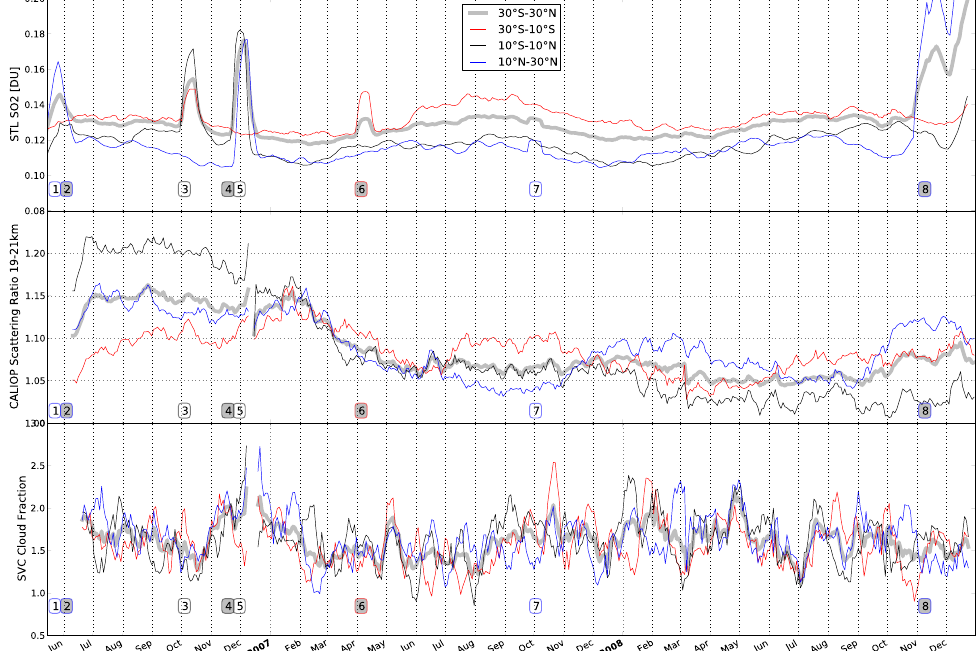
Fig. 12. Top: daily SO 2 concentrations observed by OMI (STL data from OMSO 2 product v.3). Middle: daily scattering ratios observed by CALIOP between 19 and 21km in the same latitude band (CALIOP level 1 data v.3.02). Efforts were made to remove observations affected by the South Atlantic Anomaly. Bottom: daily SVC cloud fraction (percents) from the SEL2 dataset, defined as the number of CALIOP profiles in which SVC were detected on the total number of profiles. The three time series were averaged using a 15-days moving window over the Tropics ( ± 30 ◦ , thick grey line) and three equal bands of latitude: 30–10 ◦ S (red), 10 ◦ S–10 ◦ N (black) and 10–30 ◦ N (blue). Numbers refer to the eruptions listed in Table 4 and are located on the dates of eruption. The color of their outlines documents the latitude band in which the eruptions occurred, and grey background indicates the eruption failed to reach the